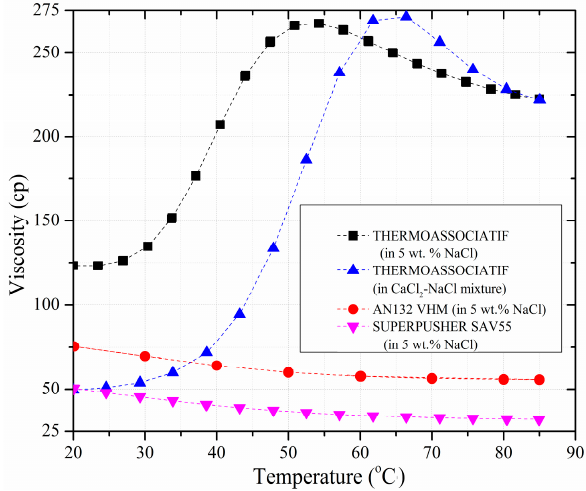
Figure 4. Comparison of rheological profiles of the copolymers at 4500 ppm polymer concentration as a function of temperature.